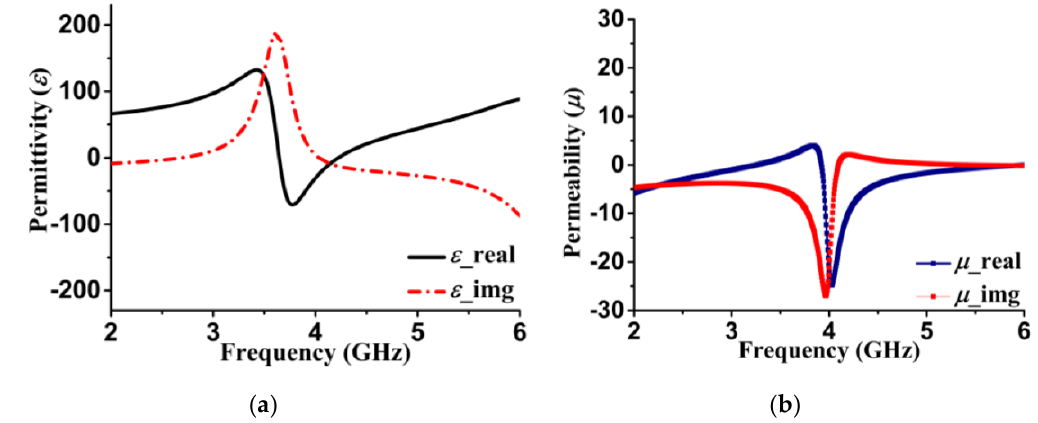
Figure 4. DNG metamaterial dielectric properties in simulation: ( a ) Permittivity (ε) and ( b ) permeability (µ).